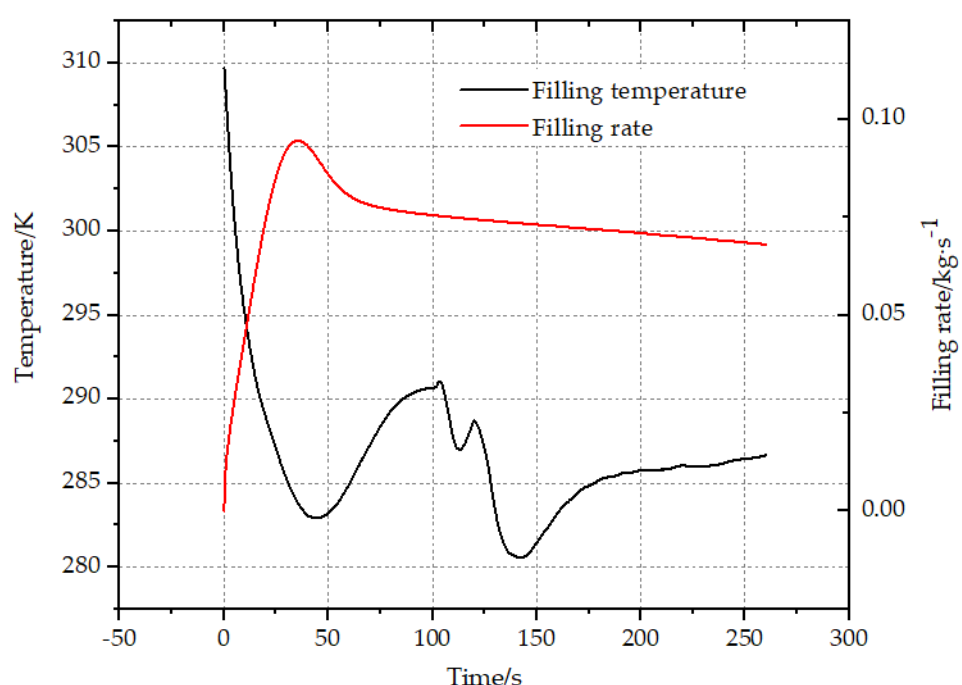
Energies 2022 , 15 , x FOR PEER REVIEW Figure 4. Inlet temperature and mass flow rate during the air filling process. Figure 4. Inlet temperature and mass flow rate during the air filling process.